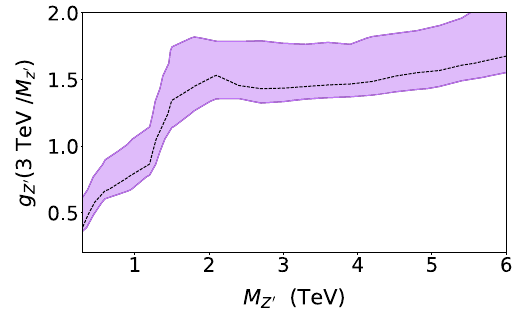
Fig. 19 EffectsoftheoreticaluncertaintiesonboundsfromtheATLAS di-muon search [52].The dashed black line shows the central limit. The purple region falls between bounds obtained from upper and lower estimates of the cross-section accounting for systematic uncertainties. Toward the extreme left-hand side of the plot, our predictions become more inaccurate due to unaccounted-for O ( M 2 tions